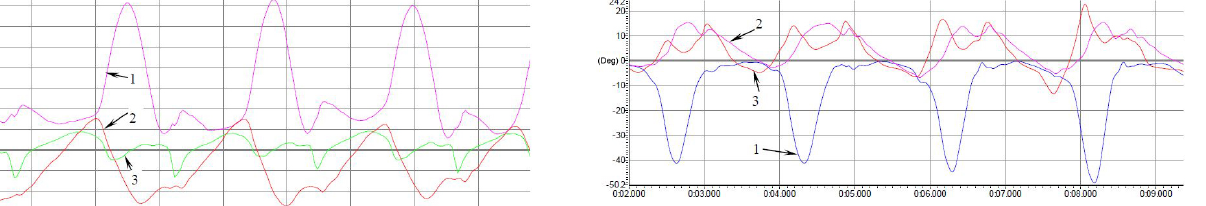
Figure 4. 1 – left knee flexion/extension; 2 – left hip flex- ion/extension; 3 – left ankle flexion/extension; Healthy human mea- sured hip, knee and ankle joint angle, in sagittal plane, for left leg.